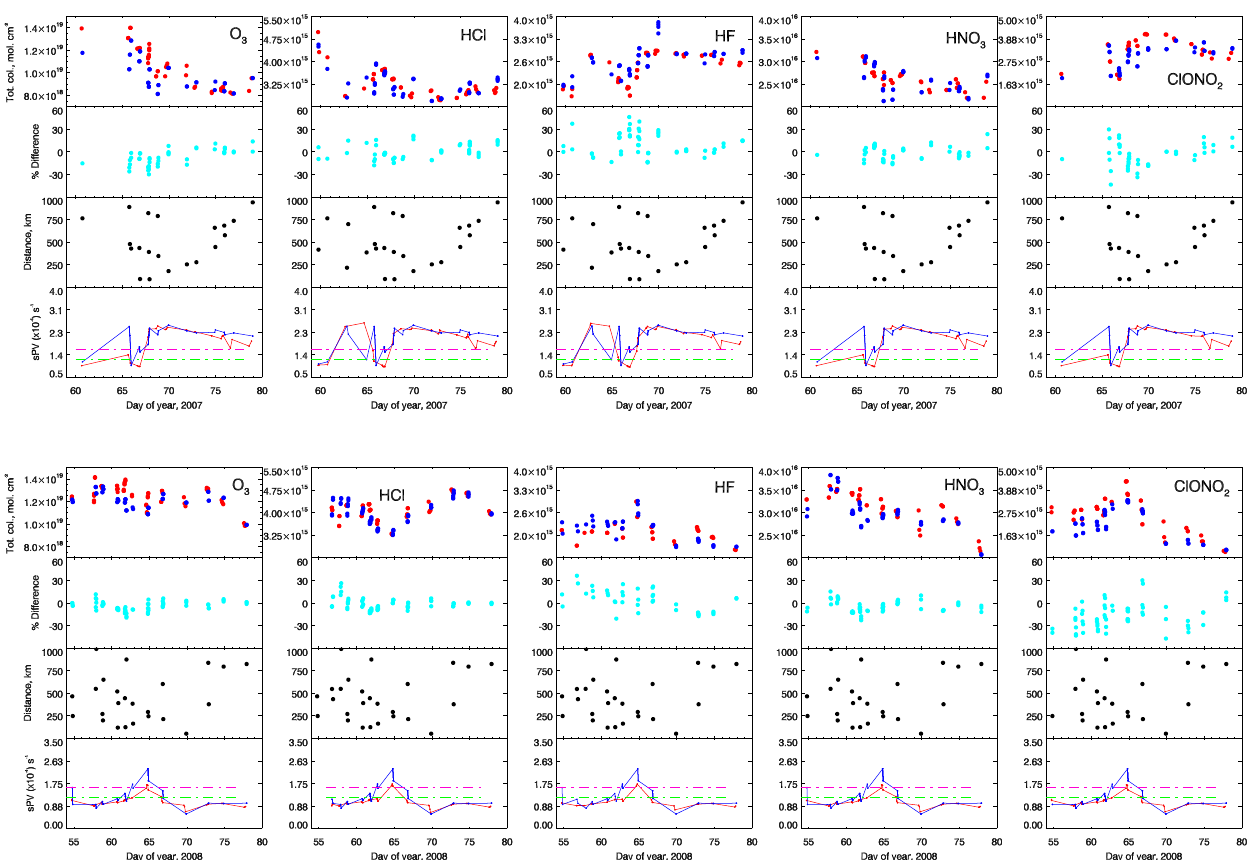
Fig. 5. Time series from 2007 (top plots) and 2008 (bottom plots) for (from left to right) O 3 , HCl, HF, HNO 3 and ClONO 2 . For each sub-plot, from top to bottom: Partial columns determined for ACE-FTS (blue) and 125HR (red); the percentage difference between the ACE-FTS and 125HR partial columns ((ACE-FTS – 125HR)/125HR); the distance between the two measurements as measured from the ACE 30-km tangent point to PEARL; and the sPV for both ACE-FTS (red) and 125HR (blue) at 18km. The vortex edge region is marked by green dashed (outer) and magenta dashed (inner)